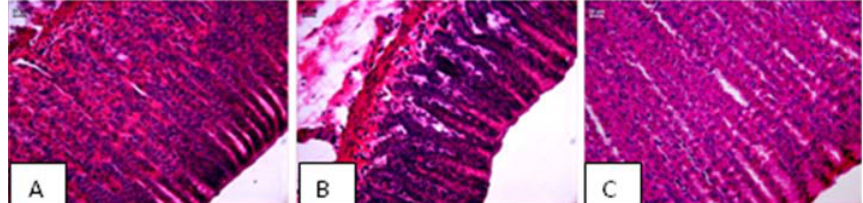
Figure 3. Photomicrography of stomach gastric ulceration caused by ethanol.